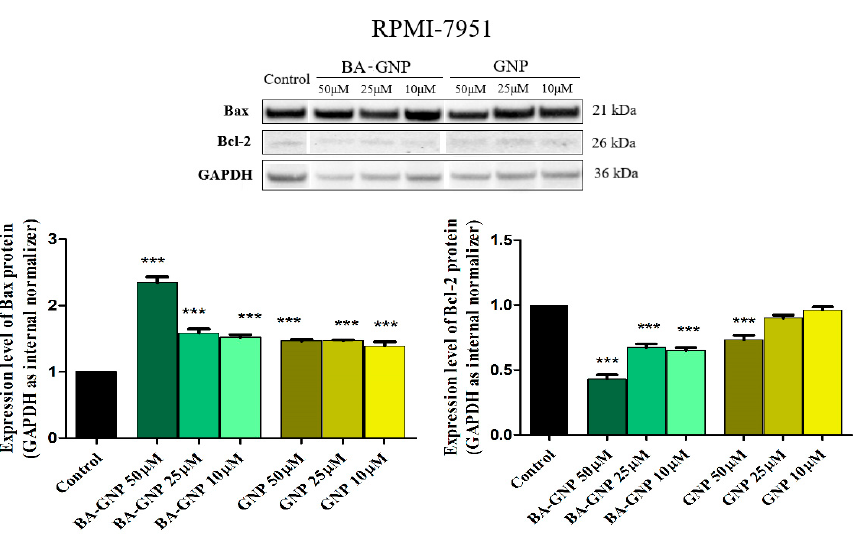
Figure 14. Determination of Bax and Bcl-2 protein expression in RPMI-7951 cells. Protein extracts from whole cells were prepared and equal amounts of protein (25 µ g per lane) were separated by Bolt™ 4–12%, Bis-Tris, and polyacrylamide gels. After transfer on the nitrocellulose membrane, immunodetection was carried out using anti-Bcl-2 and anti-Bax antibodies. The data represent the mean values ± SD of three independent experiments after normalization against the GAPDH loading control and the control group. The statistical differences vs. control were determined using one-way ANOVA analysis followed by Tukey’s multiple comparisons post-test (*** p < 0.0001).